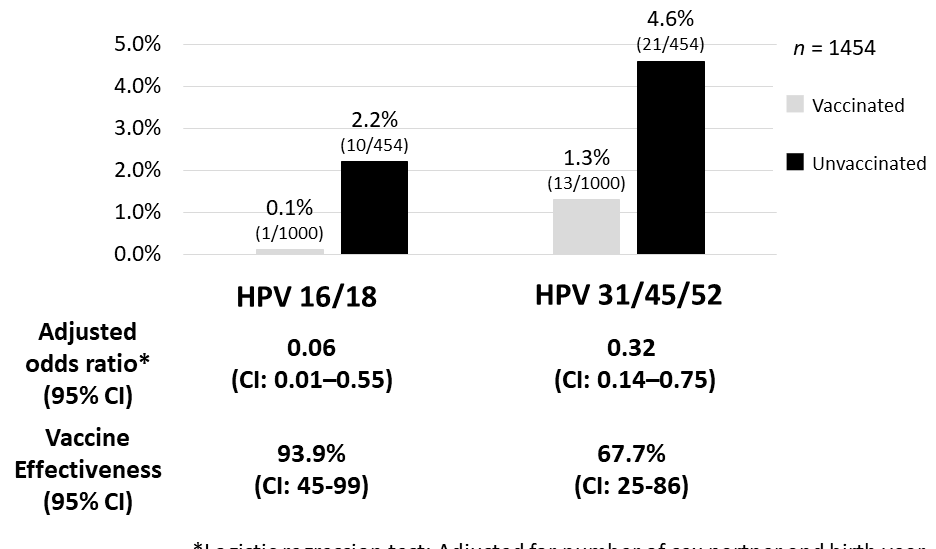
Figure 1. Adjusted vaccine effectiveness against pooled HPV 16/18 and HPV 31/45/52. Whereas the HPV types 16/18 infection rate among the vaccinated group was 0.1%, the infection rate among the unvaccinated group was 2.2%, which indicated a high vaccine effectiveness in the group of women vaccinated before their first intercourse (93.9%). The prevalence of cross-protected types of HPV 31/45/52 was also significantly lower in the vaccinated group where the vaccine effectiveness was 67.7% [6].